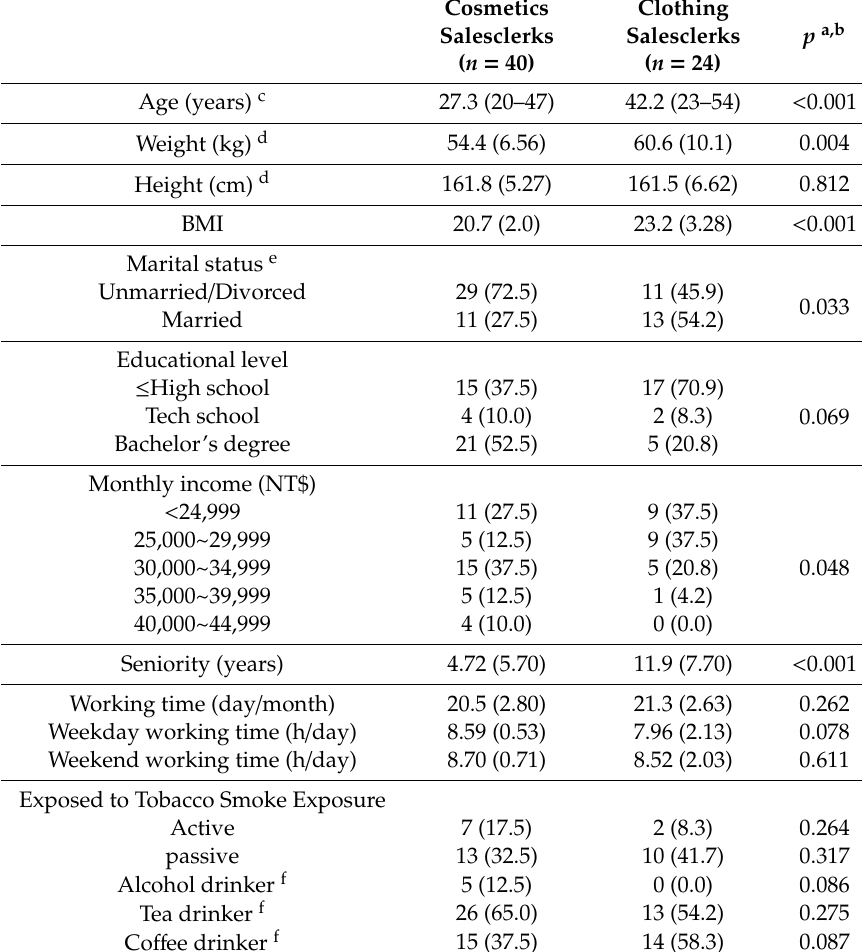
Table 3. Demographic characteristics of the study population grouped by sampling